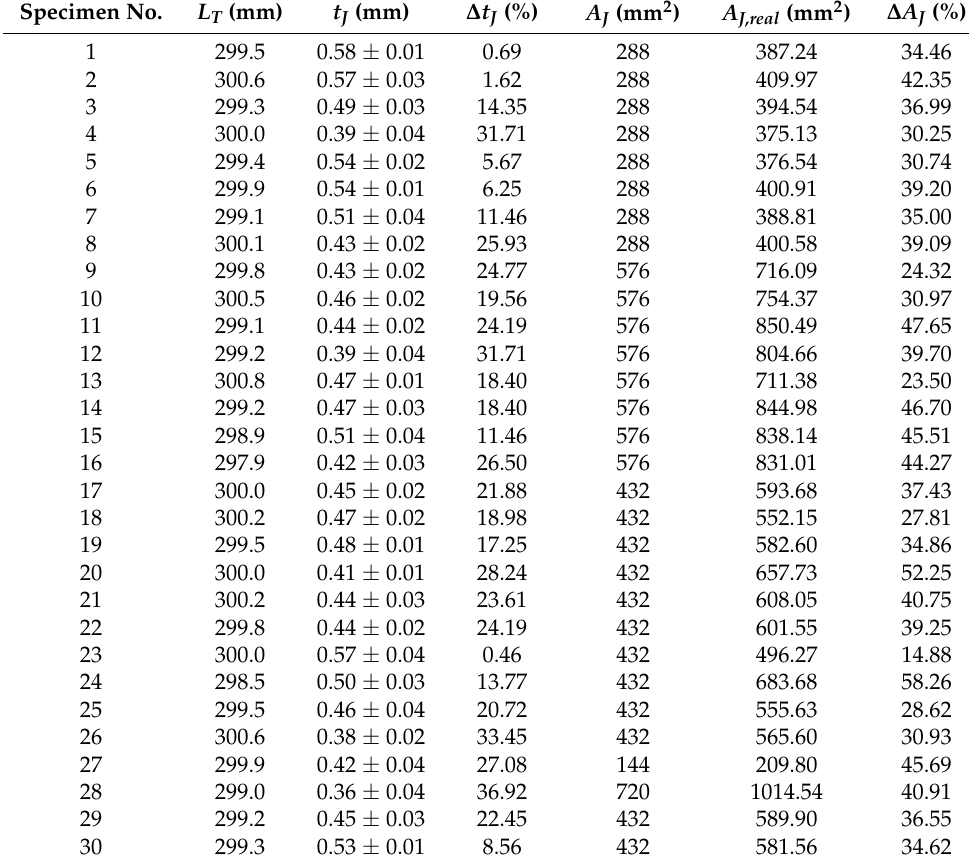
Figure 8. Joint area measurements of specimens ( a ) #26 and ( b ) #9 (not to scale). Table 6. Dimensions of the single-lapped specimens after